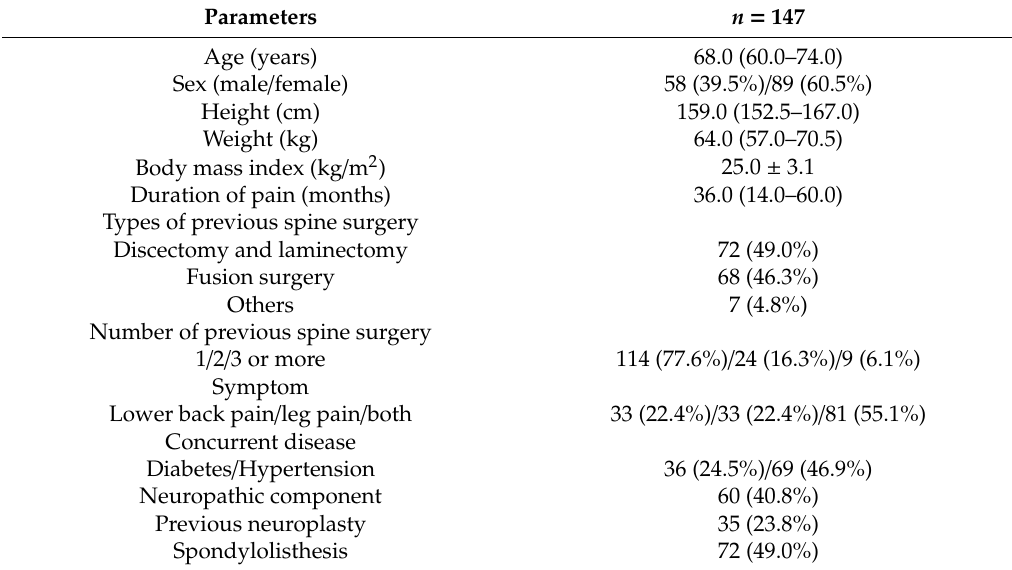
Table 1. Baseline characteristics of the study subjects.